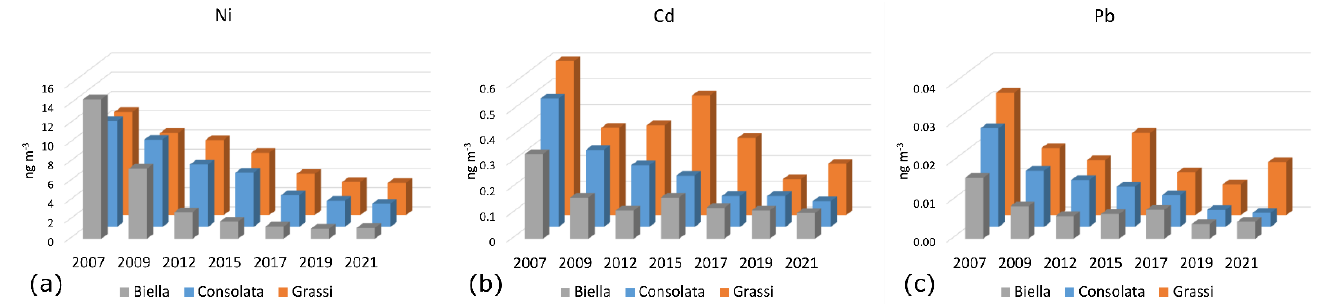
Figure 9. The trends of the mean concentration of ( a ) Ni, ( b ) Cd, and ( c ) Pb in PM 10 from Turin (Consolata, Grassi) and Biella from 2007 to 2021. Only the data of the months of April, July, August, November and December of each year have been considered. The data have been provided by ARPA Piedmont (https://aria.ambiente.piemonte.it/#/qualita-aria/dati; accessed on 30 November 2022).